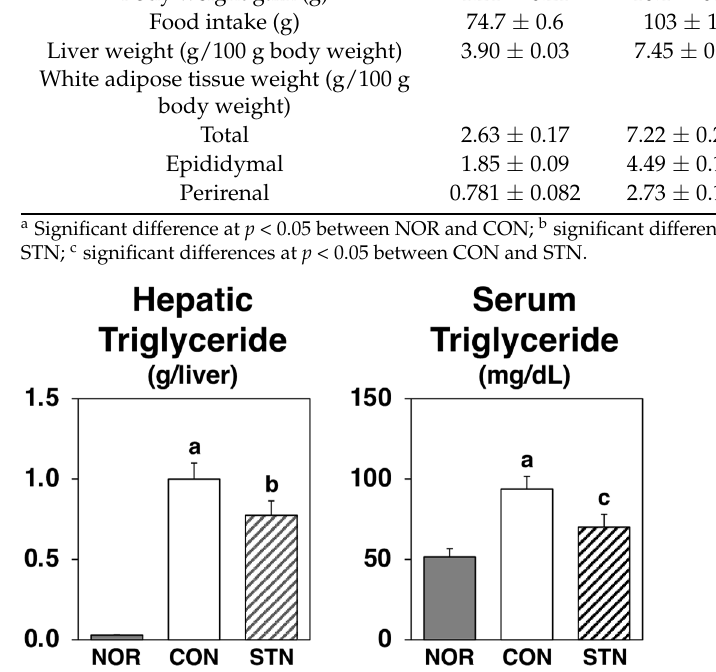
Figure 1. Triglyceride levels in the liver and serum of C57BL/6J and db / db mice fed experimental diets for 4 weeks. Values are expressed as the mean ± standard error ( n = 5). a Significant difference at p < 0.05 between NOR and CON; b significant differences at p < 0.05 between NOR and STN; c significant differences at p < 0.05 between CON and STN.